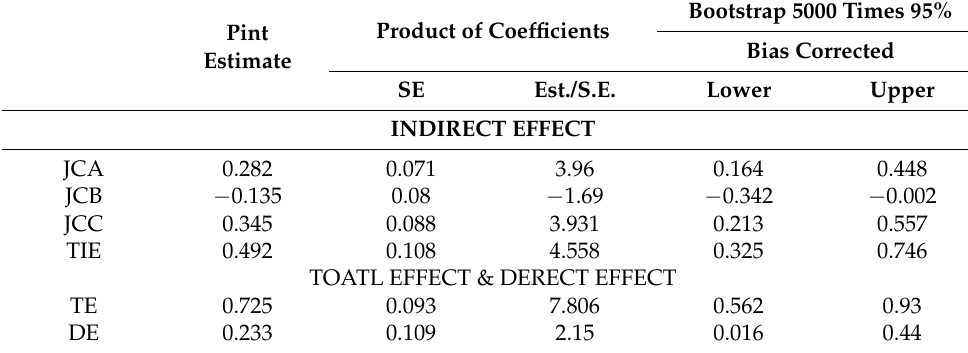
Table 4. The effect of inclusive leadership on IWB through job crafting